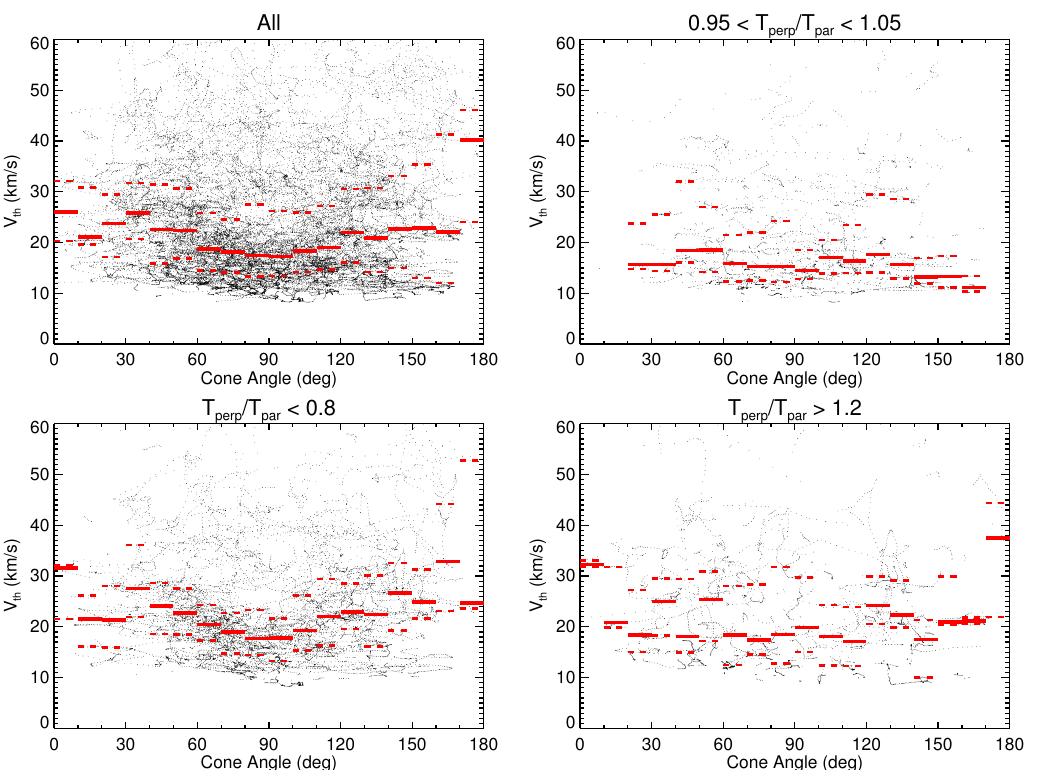
Figure 5. The dependence of the thermal speed, V th as a function of the cone angle in different ranges of temperature anisotropy: all analyzed events (top left); 0.95 < T ⊥ / T (cid:107) < 1.05 (top right); T ⊥ / T (cid:107) < 0.8 (bottom left); and T ⊥ / T (cid:107) > 1.2 (bottom